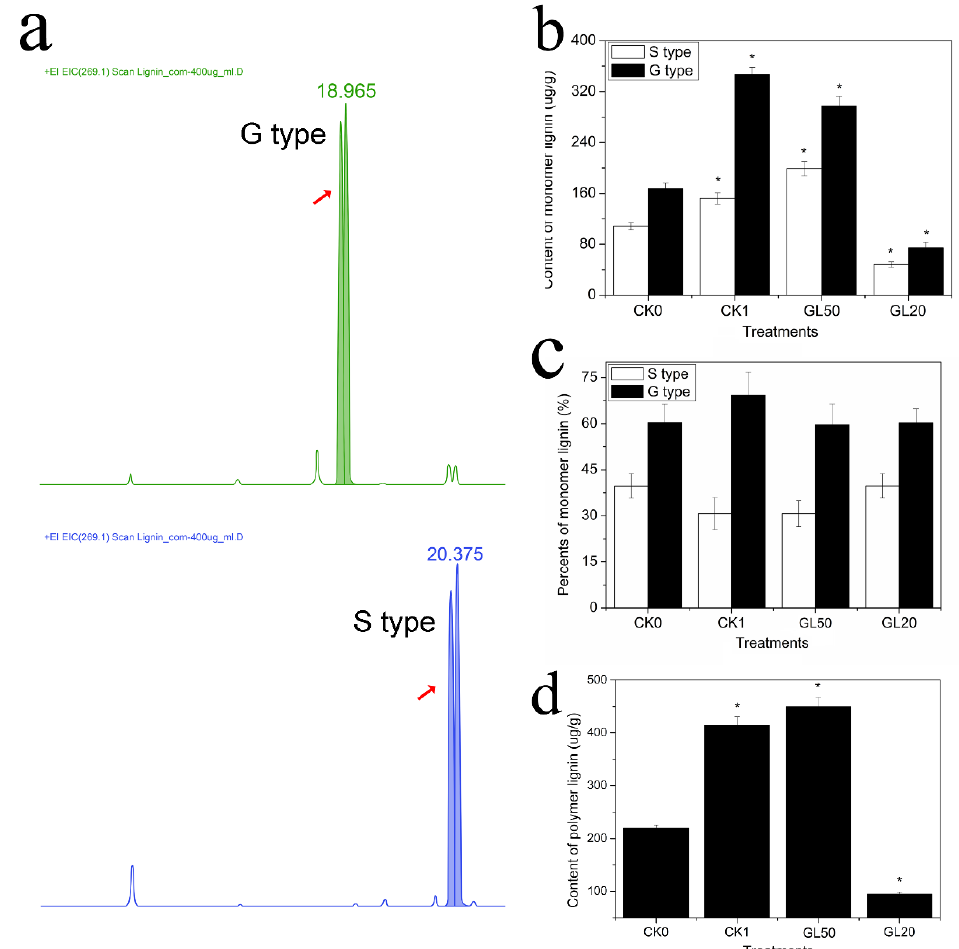
Figure 3. Identification of the lignin content in lotus seedlings treated with 20 g/L and 50 g/L sucrose during ARs formation. ( a ) The lignin was analyzed by ESI-QTRAP-MS/MS (Electrospray Ionization Quadrupole Ion TRAP Mass Spectrum/Mass Spectrum). ( b ) Determination of the monomer lignin content in the CK0, CK1, GL50, and GL20 libraries. ( c ) Determination of the monomer lignin types in the CK0, CK1, GL50, and GL20 libraries. ( d ) Analysis of polymer lignin content in the CK0, CK1, GL50, and GL20 libraries. (Red arrow represents acquisition time of G-type and S-type lignin, “*” represents significant difference at 0.05 level, p <